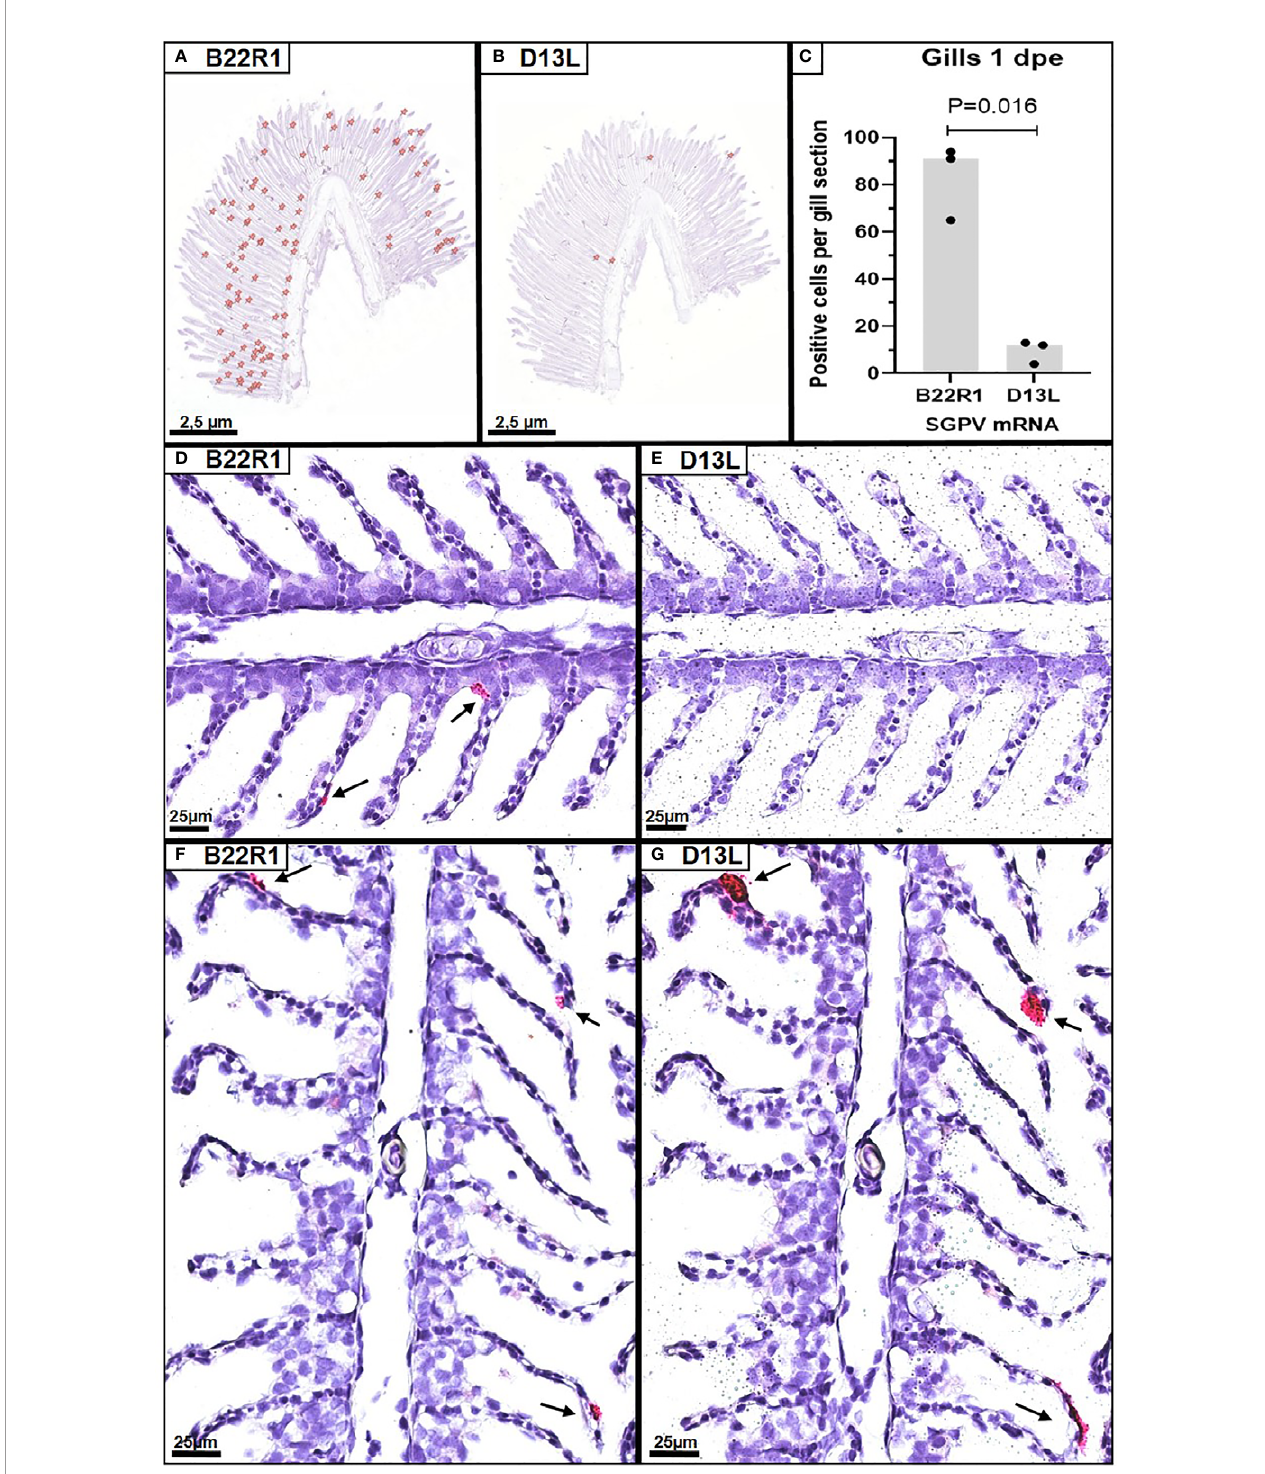
FIGURE 2 | Singleplex in situ hybridization (RNAscope) showing detection of SGPV B22R1 and D13L transcripts in gills from Atlantic salmon at 1 and 3 days after exposure to SGPV (dpe). Whole gill serial sections from 1 dpe (n=3) were scanned for staining of B22R1 and D13L RNA, as marked (A, B) , revealing signi fi cant differences in detection of SGPV-positive cells (C) . Images of the SGPV-exposed sham injected (E.S) group from 1 dpe stained with B22R1 probe (D) and D13L probe (E) . Serial section from the E.S group from 3 dpe stained with B22R1 probe (F) and D13L probe (G)